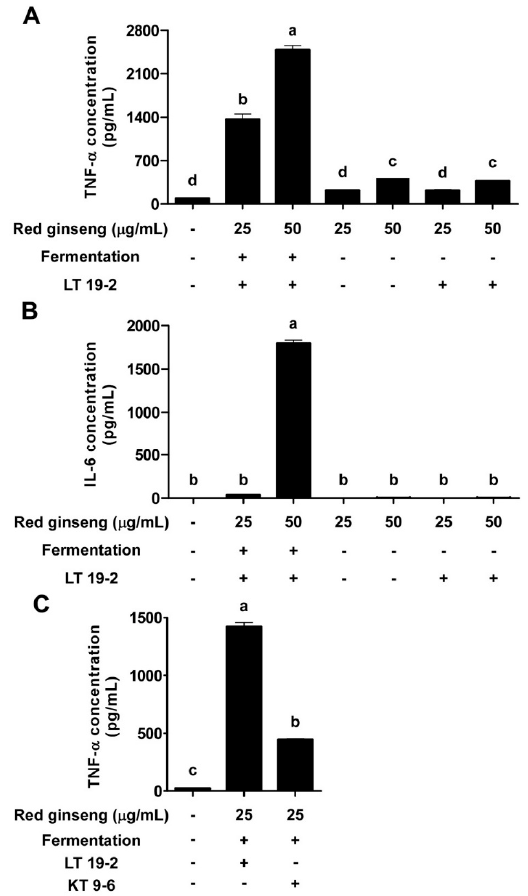
Figure 4. Effects of FRG on TNF- α and IL-6 production. ( A ), ( B ) RAW264.7 cells were treated with FRG at the indicated concentrations, and the media was collected after 6 h for ( A ) TNF- α and ( B ) IL-